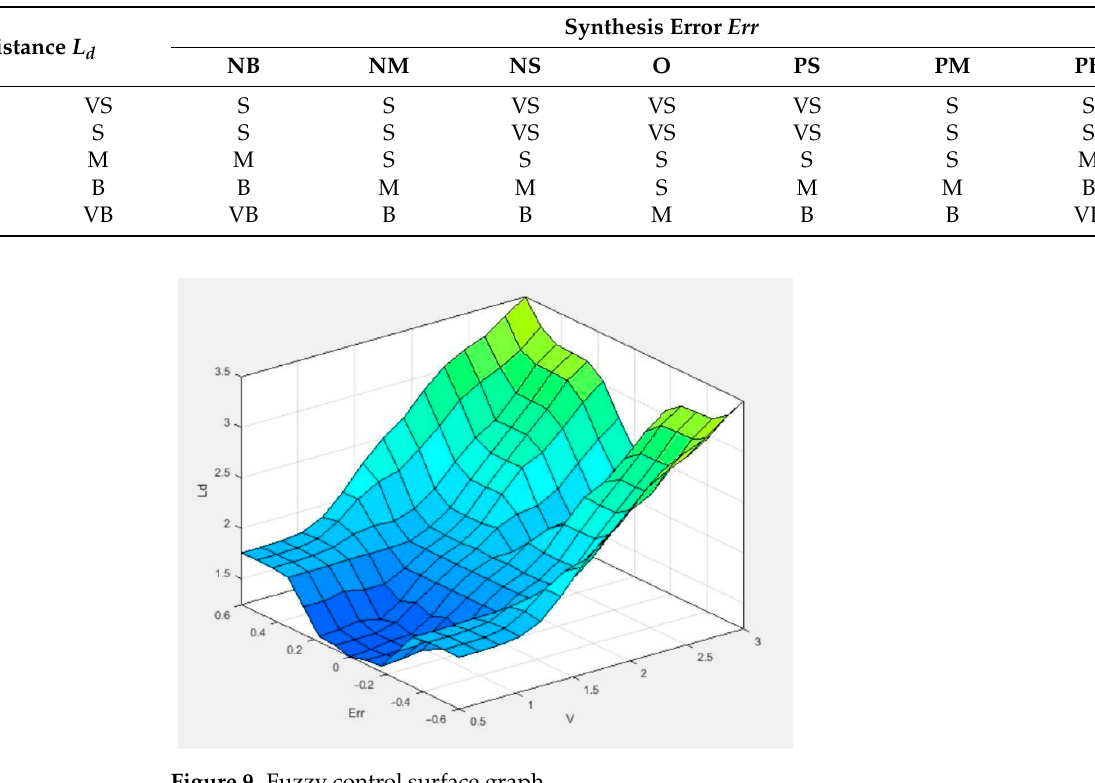
Table 1. Fuzzy control rule table.